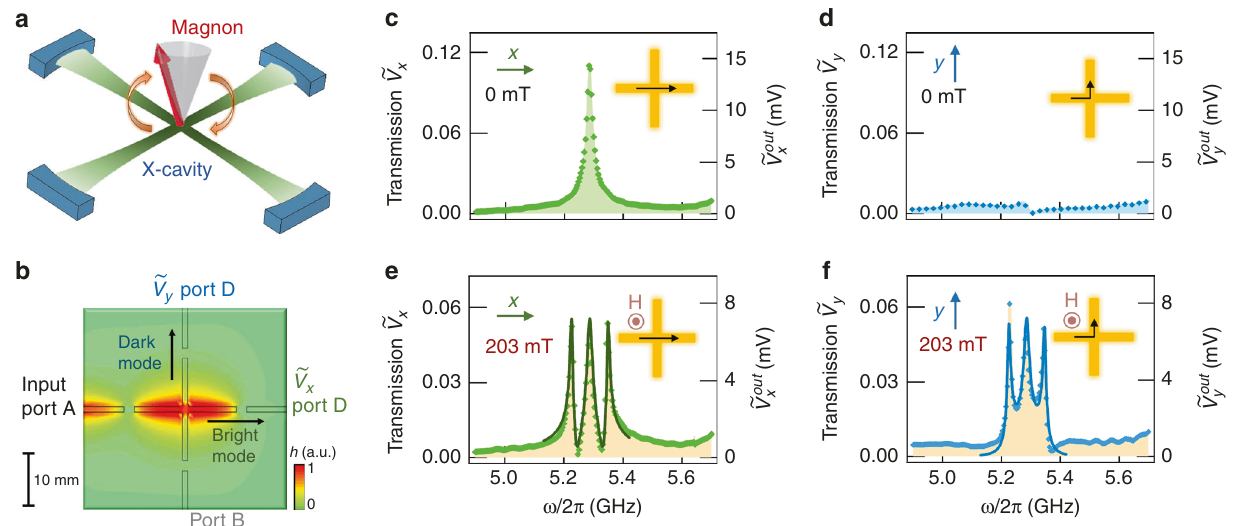
Fig. 1 Construction of X-CMP. a Schematic fi gure of a magnon coupled to a cross-cavity. b Simulated microwave fi eld distribution for the fundamental mode showing that microwave propagation is con fi ned along the x -direction when the microwaves are sent through port A, with scale bar showing the dimension and the color scale showing the normalized amplitude of microwave magnetic fi eld ( h ). c x -direction and d y -direction microwave transmission spectra (left axis) as well as output voltage (right axis) measured at 0 mT. e x -direction and f y -direction microwave transmission spectra (left axis) as well as output voltage (right axis) measured at 203 mT, solid lines shows the calculated results from an analog to the dynamic Hall model